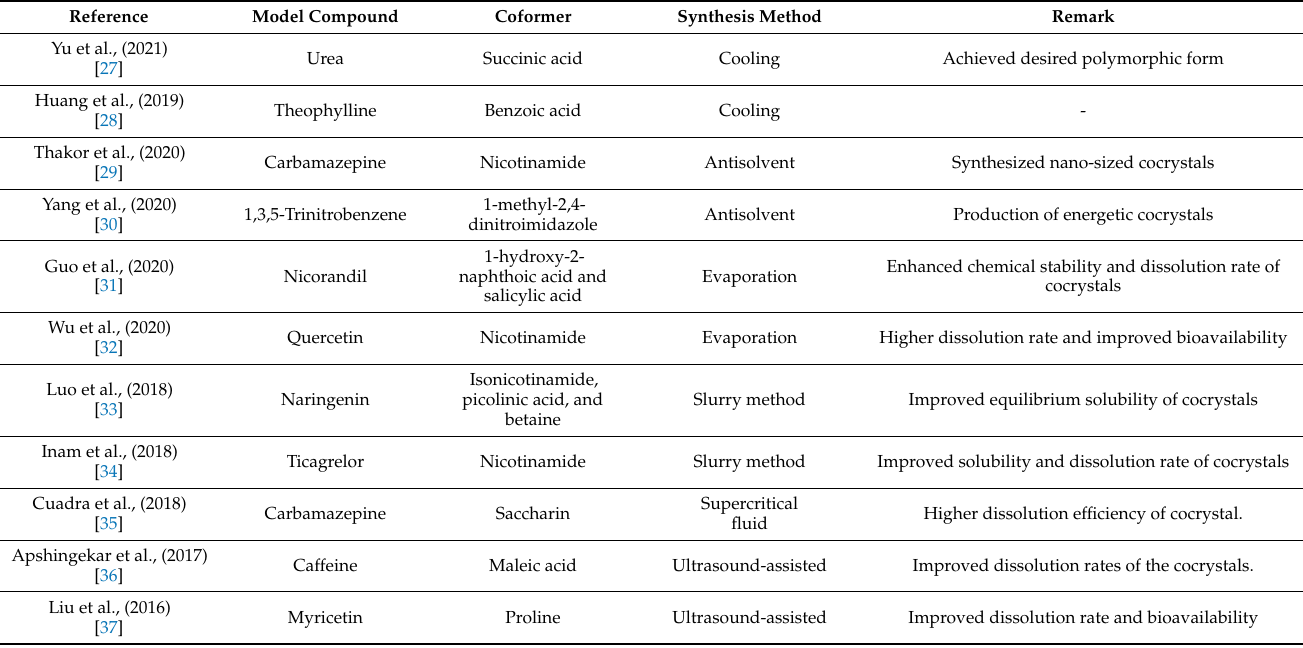
Table 2. Application of various solution cocrystallization for the synthesis of